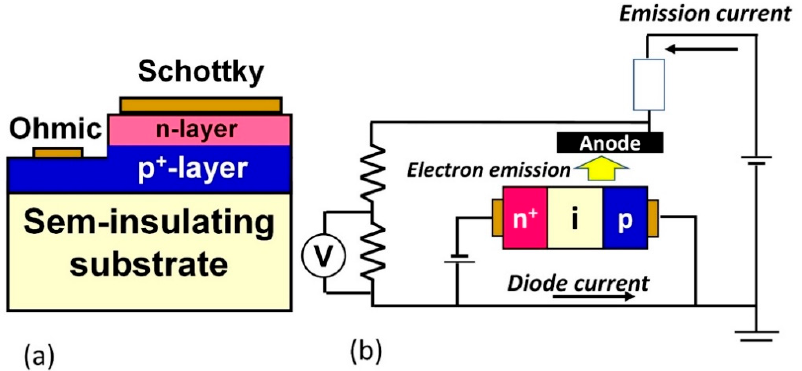
Figure 11. Schematic illustrations of noble diamond diodes. ( a ) Schottky pn diode (SPND). ( b ) Vac- uum switch utilizing highly efficient electron emission from diamond PiN diode.